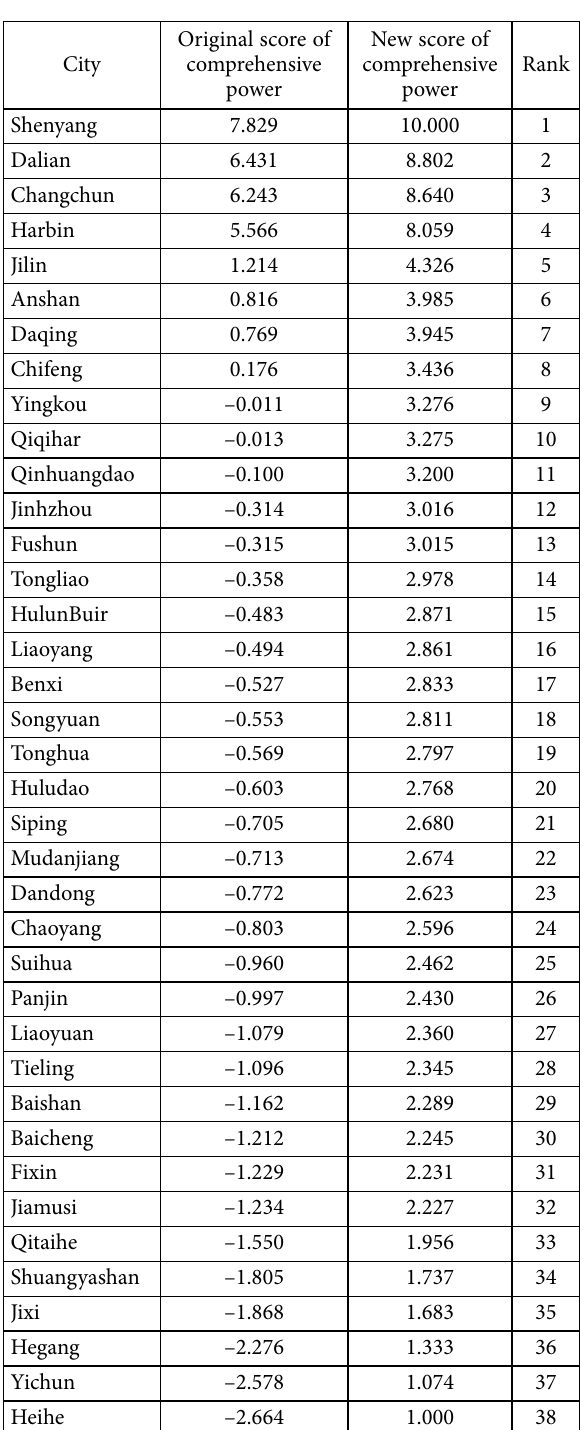
Table 3. The comprehensive power ranking of cities in northeast economic zone